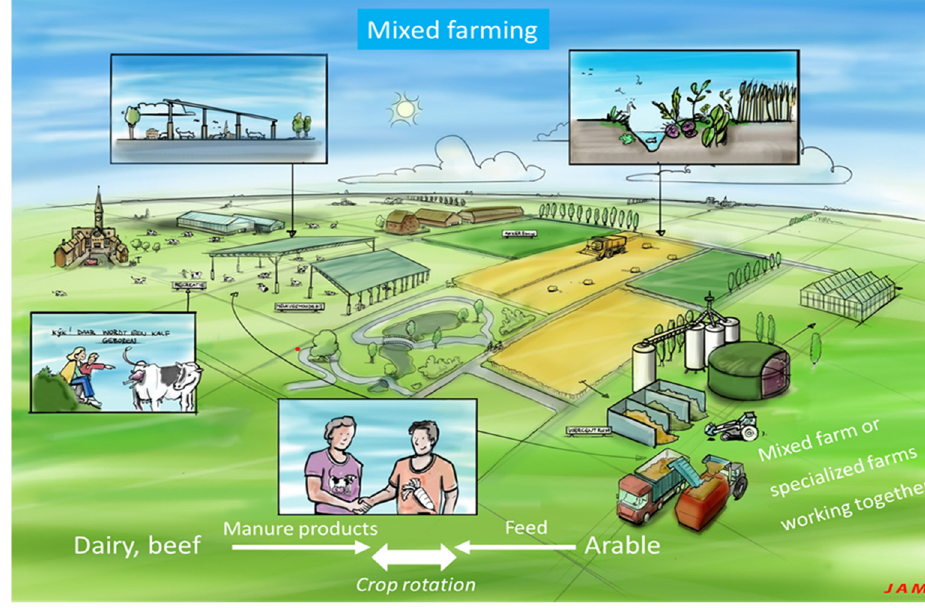
Figure 7. Mixed farming as a system realizing a circular economy. Source: Authors.